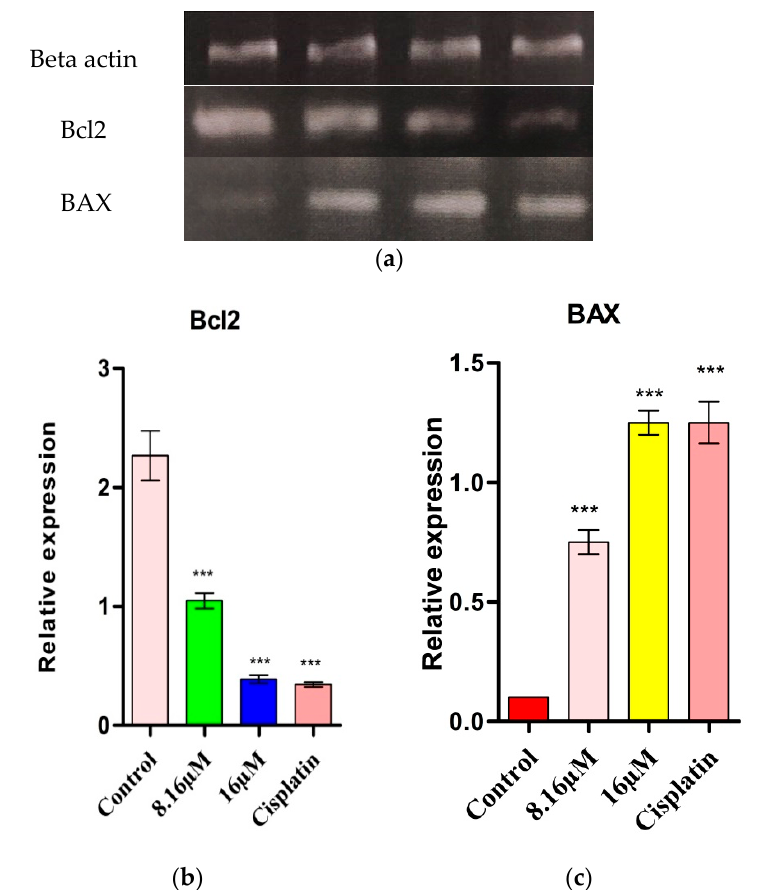
Figure 3. ( a ) The relative gene expression of BAX in treated HT-29 along with the control and cisplatin. ( b ) The relative gene expression of Bcl2 in treated HT-29 along with the control and cisplatin. ( c ) The relative gene expression of Bax in treated HT-29 along with the control and positive drug cisplatin. Statistical significance is expressed as *** p < 0.0001 by using one-way